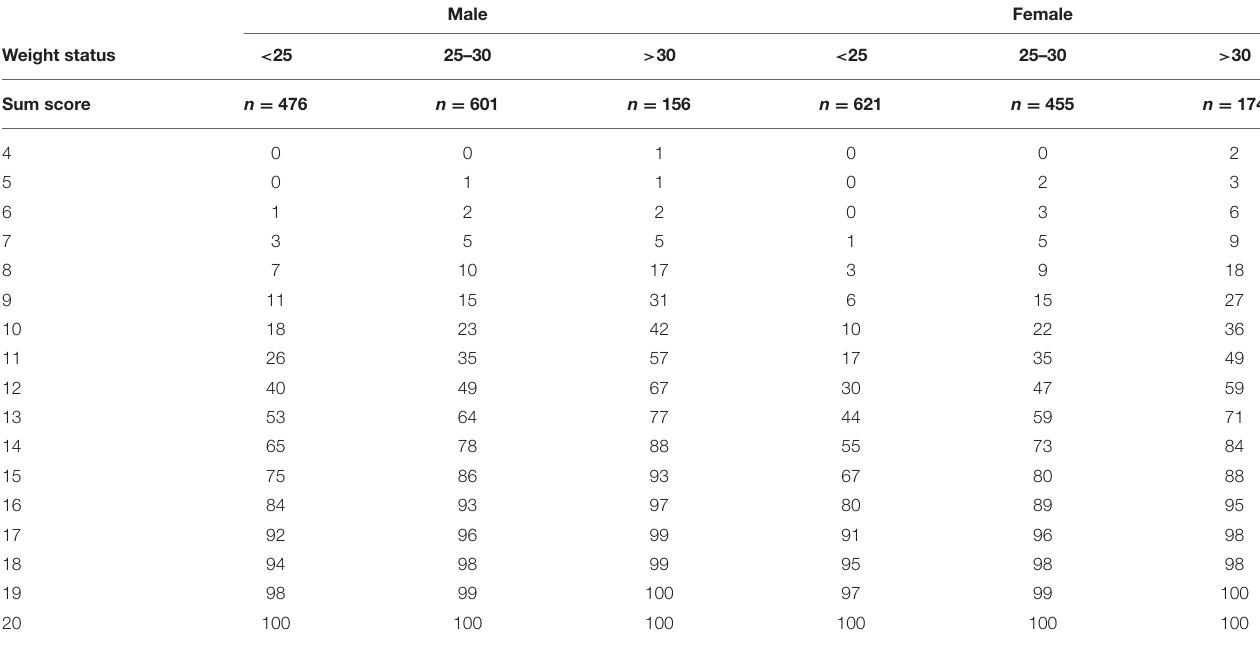
TABLE 7 | Normative percentile ranks for the Self-Regulation of Eating Behavior Questionnaire sum scores.